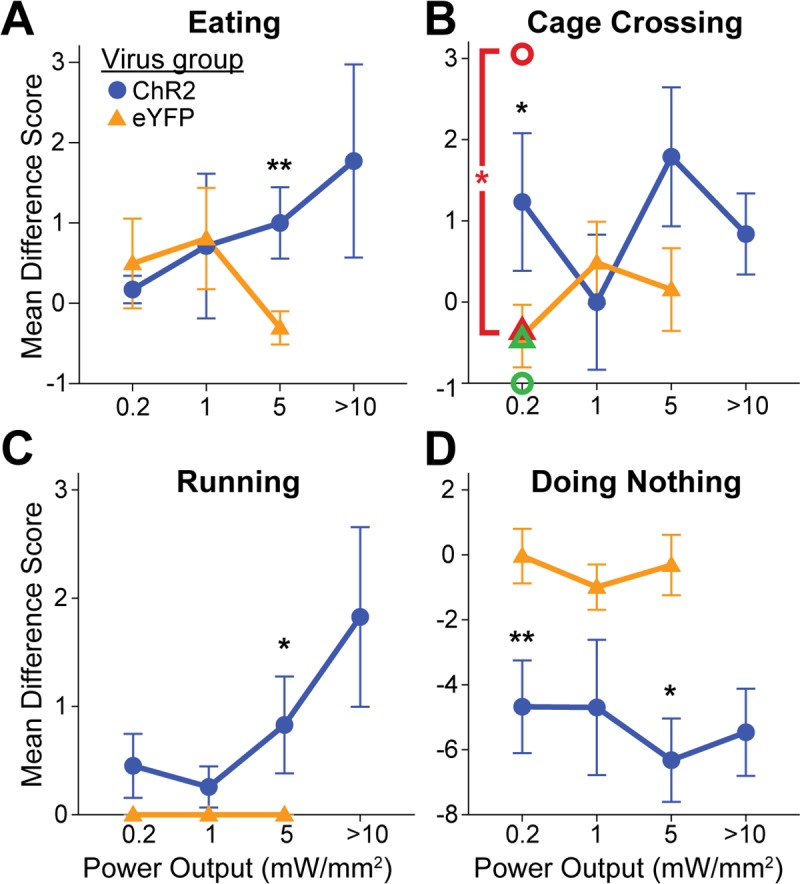
Other behavioral effects of different LH laser intensities.Line graphs depicting difference scores–derived by subtracting interim period counts from laser period counts–for eYFP and ChR2 groups at increasing laser power outputs. The behaviors depicted are eating (A), cage crossing (B), running (C), and doing nothing (D). A black asterisk denotes significant difference between eYFP and ChR2 groups at that laser power, whereas a pink asterisk denotes significant difference between eYFP female and ChR2 female groups; *: p < 0.05, **: p < 0.01. Pink and green symbols represent the means for female and male rats, respectively.